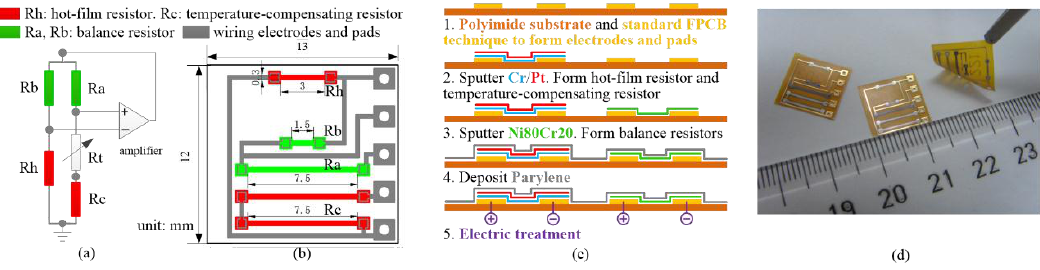
Figure 3. ( a ) CTD circuit of the flow sensor; ( b ) the design of the monolithically integrated hot-film flow sensor; ( c ) the fabrication processes of the sensor; and ( d ) fabricated sensors.